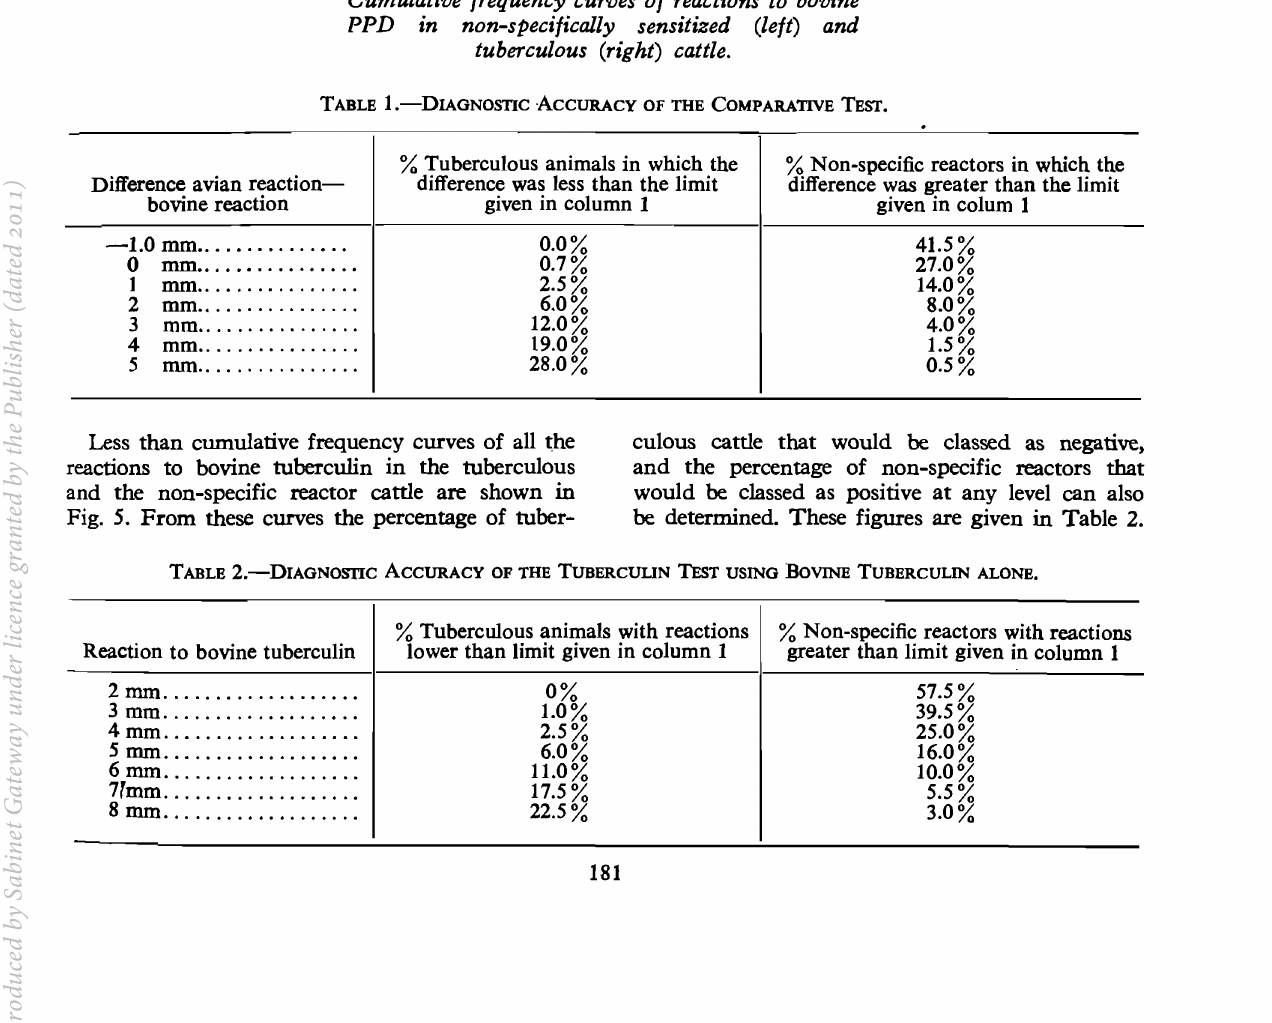
FIG. 5. Cumulative frequency curves of reactions to bovine PPD in non-specifically sensitized (left) and tuberculous (right) cattle. TABLE I.-DIAGNOSTIC ACCURACY OF THE COMPARATIVE TEST.